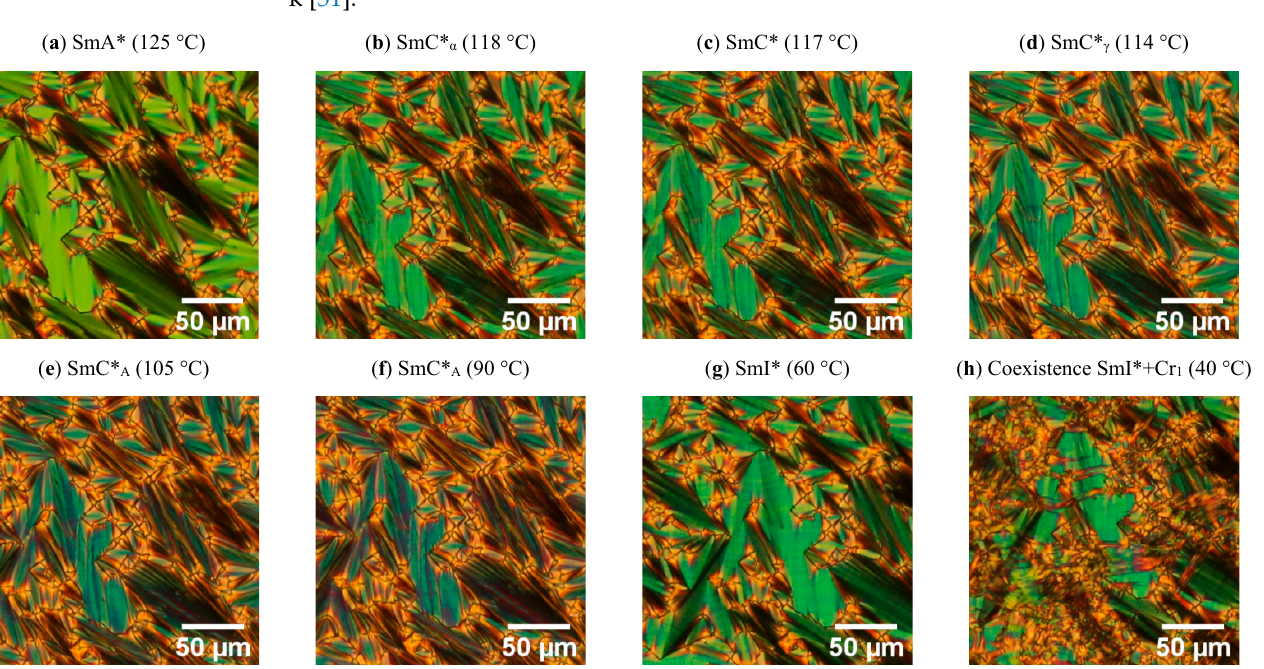
Figure 1. Textures under cross-polarizers registered during cooling with a rate of 2 ◦ C/min for Com- posite 3: SmA* ( a ), SmC* α ( b ), SmC* ( c ), SmC* γ ( d ), SmC* A at 105 ◦ C ( e ), SmC* A at 90 ◦ C ( f